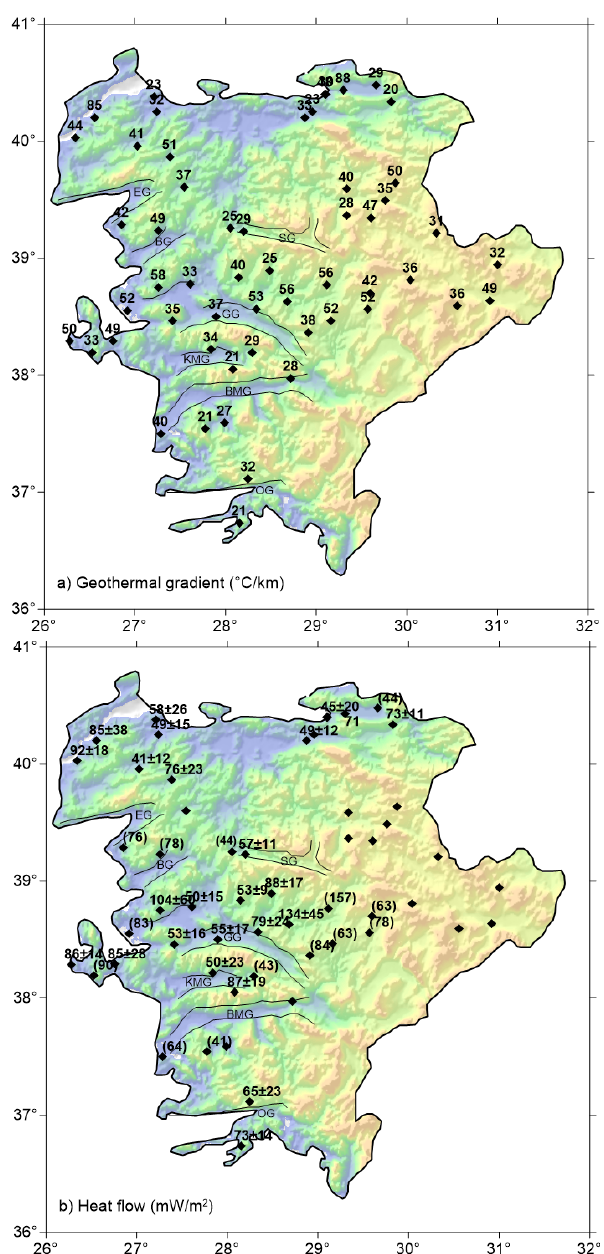
Figure 3. Regional distribution of the (a) geothermal gradients and (b) heat flow values in Table 2. Note that some sites only have gra- dient values due to the unavailability of thermal conductivity infor- mation. Black lines indicate boundaries of horst–graben structures, which are the dominant structural features in the region. GG: Gediz Graben; BMG: Büyük Menderes Graben; KMG: Küçük Menderes Graben; EG: Edremit Graben; BG: Bakırçay Graben; SG: Simav Graben; OG: Gökova Graben.